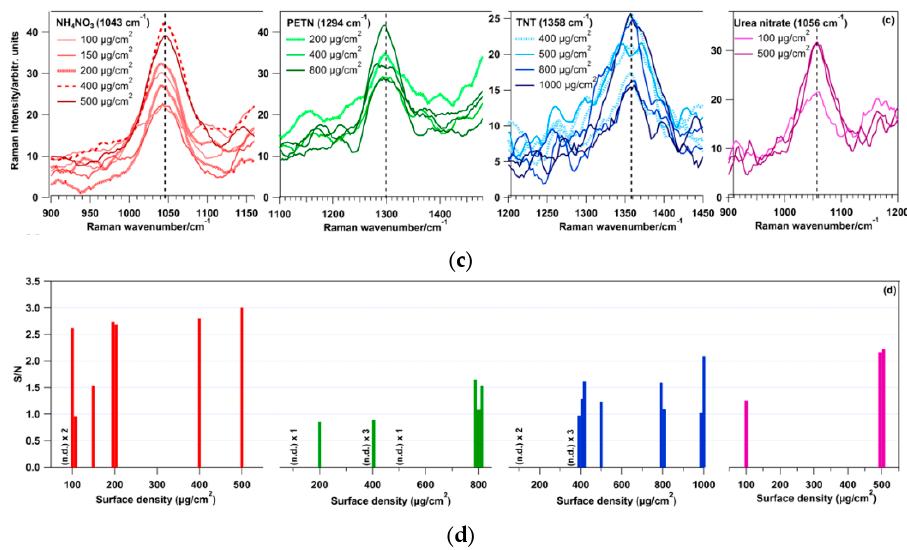
Figure 8. Raman spectra from aluminium and AN on aluminium at a distance of 7 m (266-nm single laser pulse at 3 and 6 mJ/cm 2 ) ( a ); Four different fabrics at a distance of 6.4 m (266-nm single laser pulse, 3 mJ/cm 2 ) ( b ); AN, PETN, TNT and UN at different surface densities and at a distance of 6.4 m (266-nm single laser pulse, 3 mJ/cm 2 ) ( c ); and signal to noise ratios from the Raman bands reported in ( c ) (n.d. = not detected) ( d ).